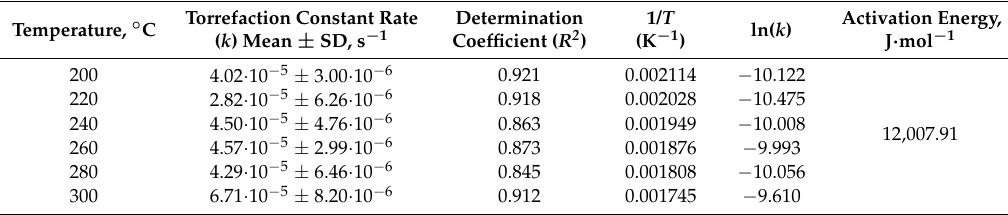
Table 3. Kinetic parameters of sewage sludge